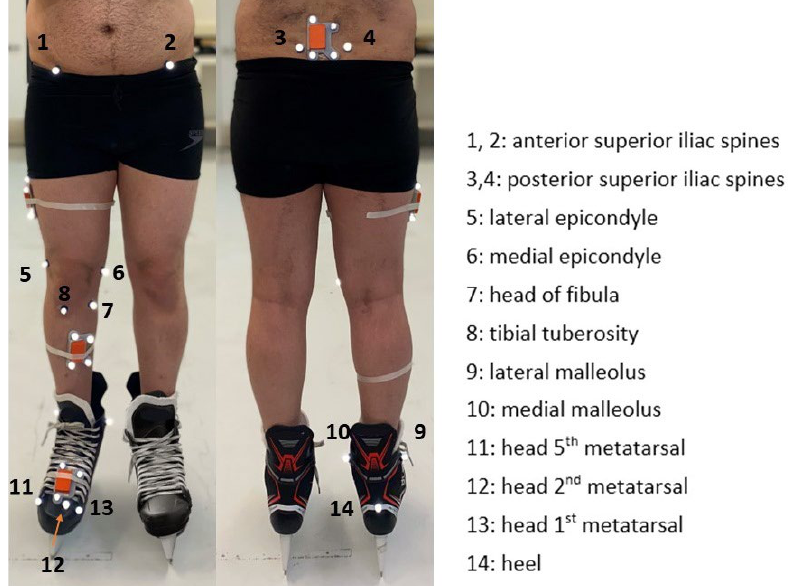
Figure 1. Four IMUs (orange boxes) were placed on the participants’ pelvis, thigh, shank, and skate of the dominant leg. Moreover, 14 retro-reflective were used for 3D joint angles estimation using a motion capture